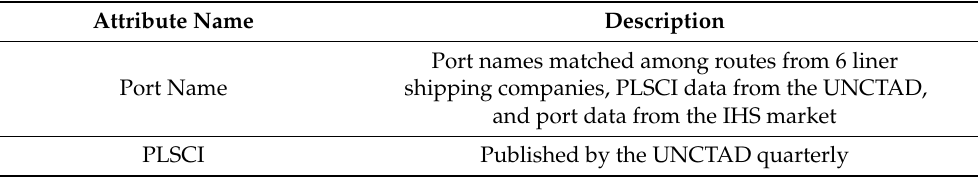
Table 1. Attributes merged and used in this study.